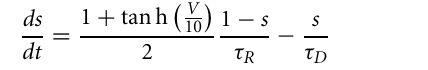
FIGURE 2 | The structure of neural network, consist of two competitive